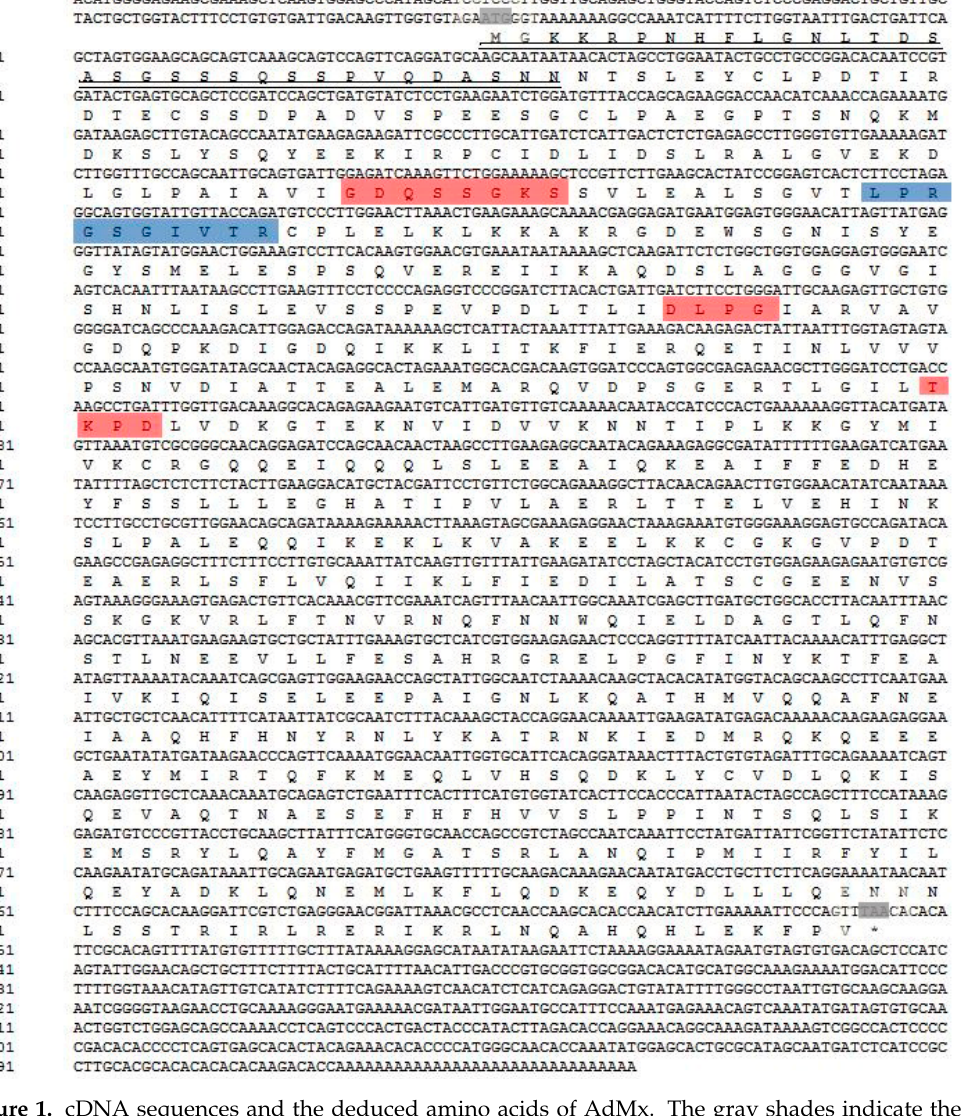
Figure 1. cDNA sequences and the deduced amino acids of AdMx. The gray shades indicate the start codon and stop codon, respectively. Predicted signal peptide is marked with double underline. The asterisk indicates peptide ending. The GTP enzyme dynamic protein superfamily tag sequences are indicated by red shades, and the triplet GTP binding region is indicated by blue shade.